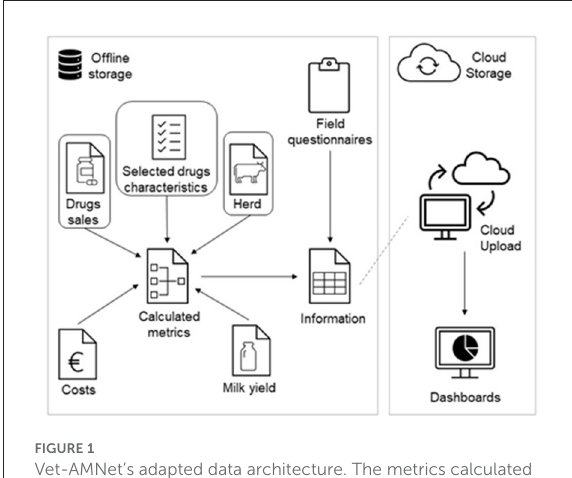
FIGURE1 Vet-AMNet’s adapted data architecture. The metrics calculated in this analysis required “drug sales,” “herd data,” and “selected drugs characteristics” as highlighted in the model.